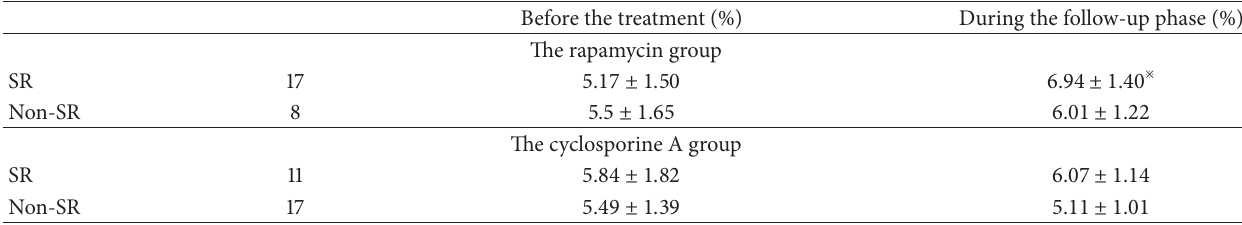
Table 4: The comparison of the Treg cells level between patients with SR and with non-SR.